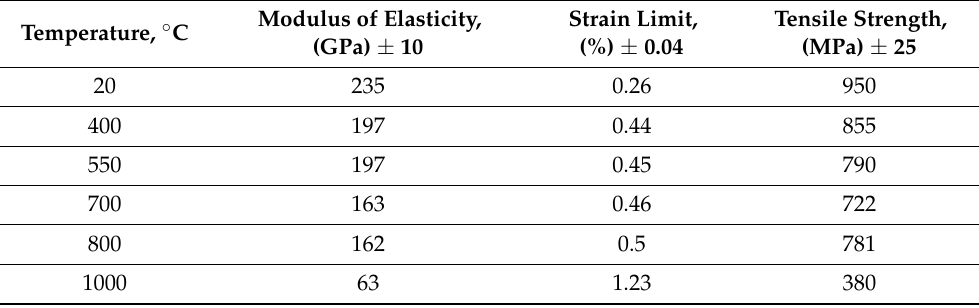
Table 3. Measurement results of elastic modulus, strain limit and strength limit as a function of temperature during bending